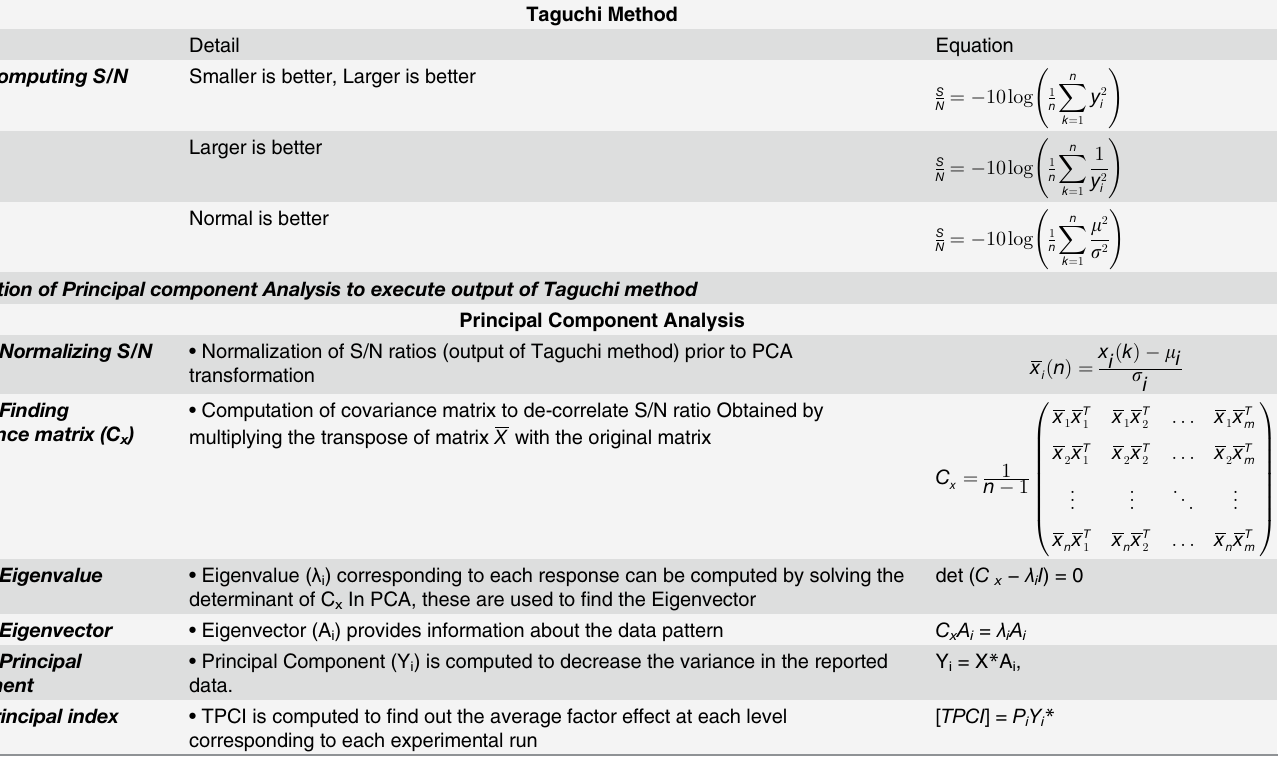
Table 6. Theoretical framework of the Taguchi method coupled with principle component analysis (PCA).